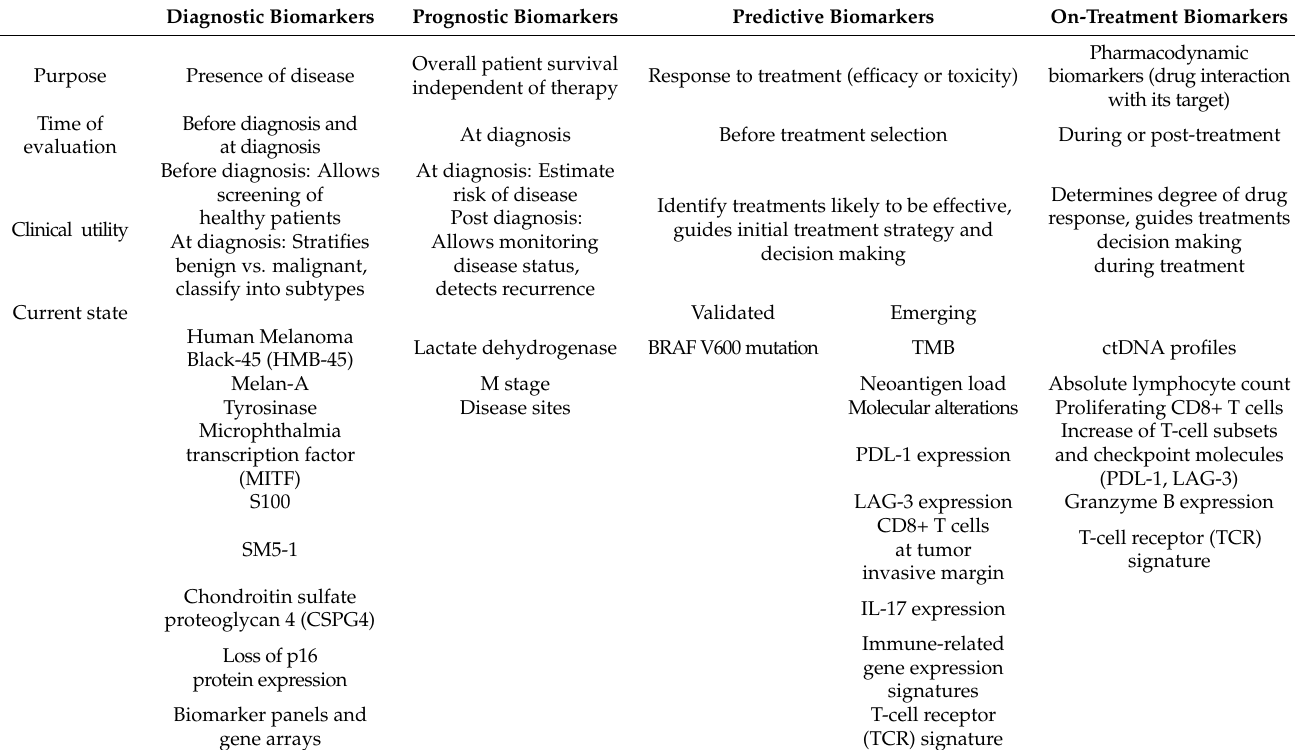
Table 2. Types of biomarkers and their clinical utility in metastatic